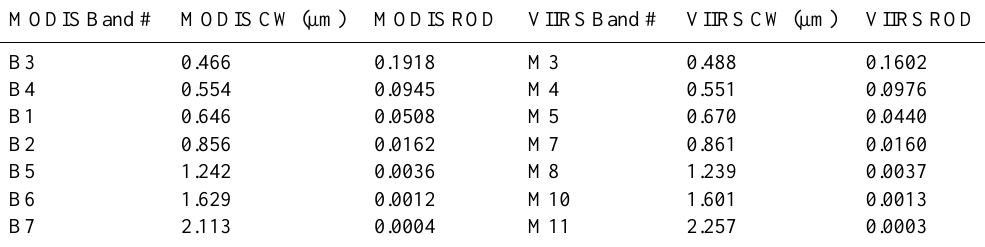
Table 4. Characteristics of MODIS and VIIRS bands used for DT retrieval, including central wavelength (CW) and Rayleigh Optical Depth